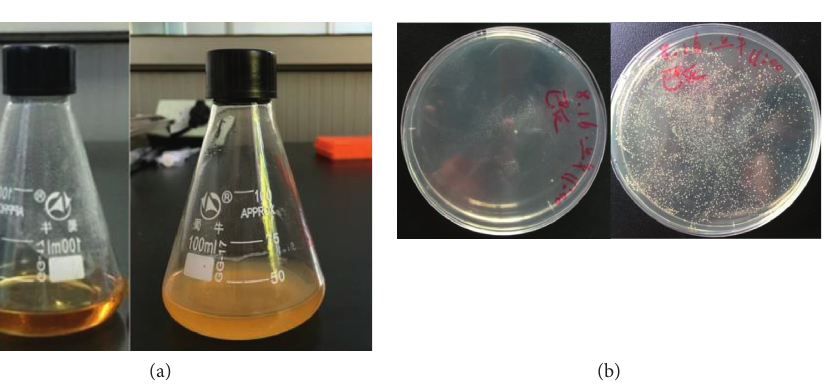
Figure 1: The appearance of Sporosarcina pasteurii in (a) liquid medium and (b) solid medium.